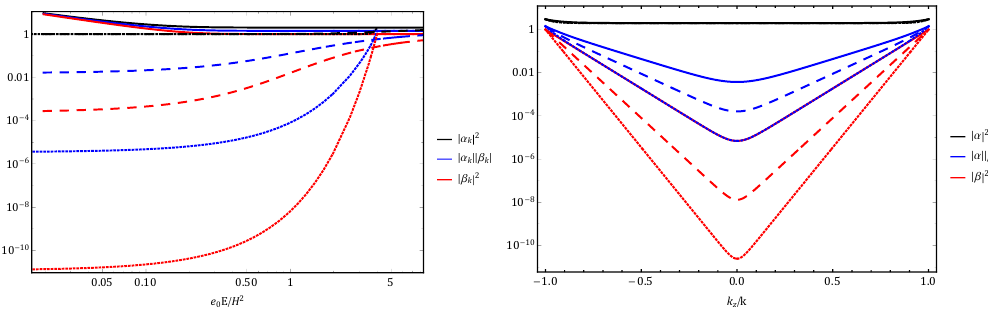
Figure 1 . The left panel of the (cid:12)gure shows the combinations of the Bogoliubov coe(cid:14)cients j (cid:11) j 2 k in black, j (cid:11) jj (cid:12) j in blue and j (cid:12) j 2 in red as a function of electric (cid:12)eld by taking k = 1. For k k k z =k the right panel, we combine the contribution of the positive charged particles and negative charged particles to the Bogoliubov coe(cid:14)cients. This contributes to the symmetry of the (cid:12)gure. The solid and dashed lines correspond to m = 3 H= 2 and 2 H respectively. The dotted line corresponds to 2 cannot exceed 4 as ~ m = p m 2 (cid:0) 9 = 4 (cid:21) 0. The (cid:12)xing j (cid:22) j = 4 and hence the electric (cid:12)eld e 0 E=H right panel of the (cid:12)gure shows the Bogoliubov coe(cid:14)cients as a function of k . The solid, dashed z =k and dotted lines represents (cid:22) = 2 i; 3 i; 4 i ,